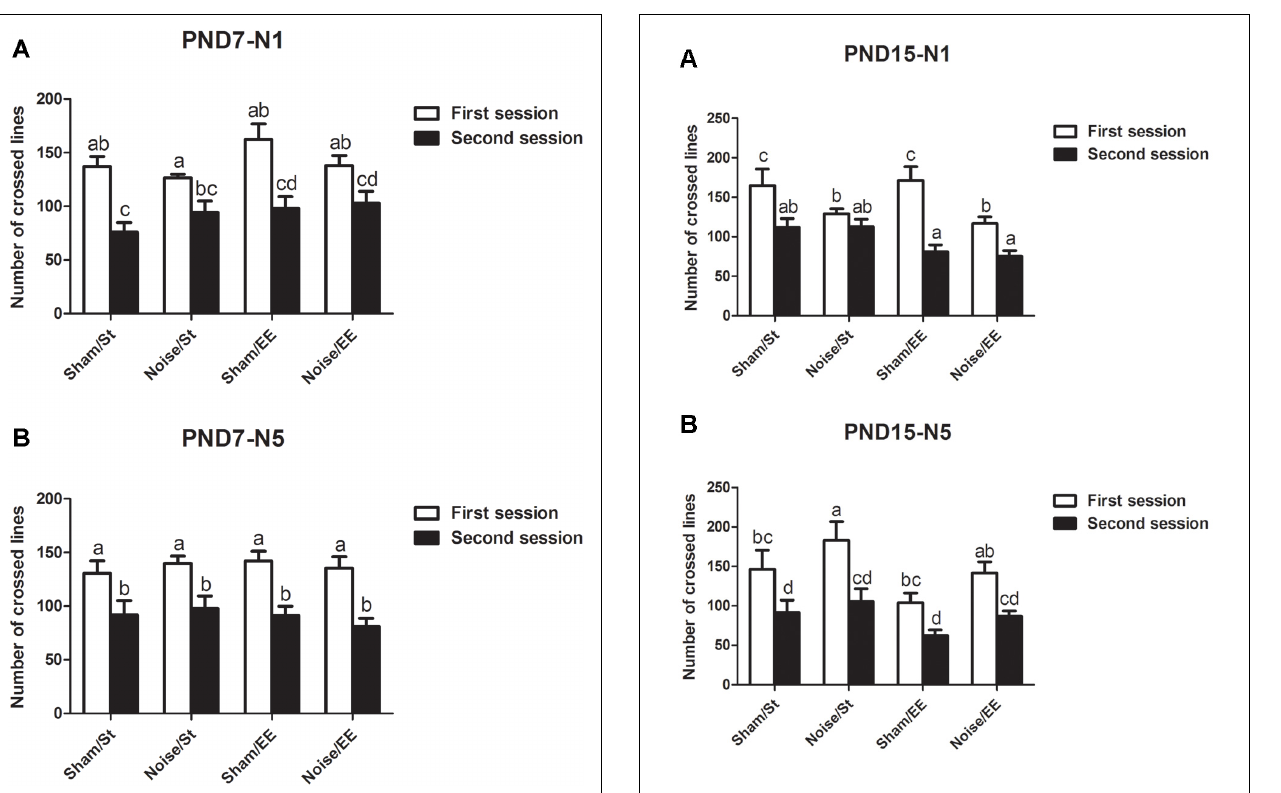
FIGURE 3 | Number of lines crossed in the first and second session of the OF by PND28 animals exposed to noise at PND7. (A) PND7 animals exposed according to N1; (B) PND7 animals exposed according to N5. Sham: non- exposed animals; N1: single noise exposure; N5: five-daily noise exposure. St: standard housing. EE: enriched environment. Different letters (a, b, c, d) symbolize significant differences with p < 0.05. Data represent the mean ± SEM of the number of lines crossed in the first and second session of the OF, n = 7 for each group.